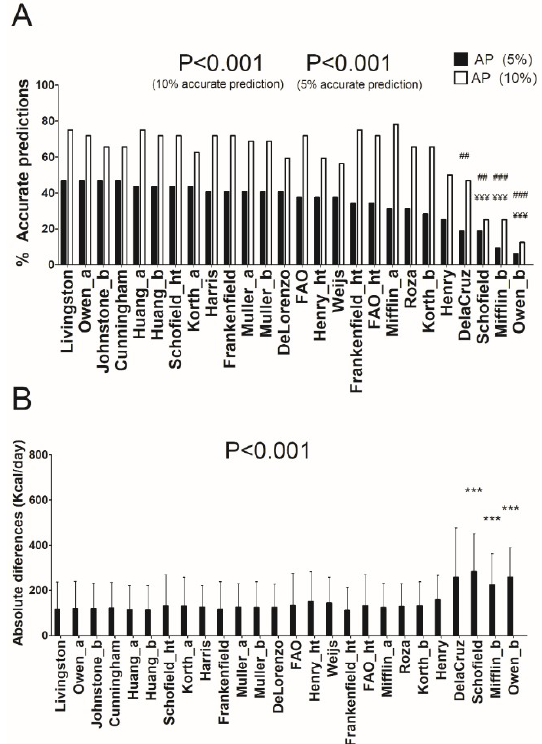
Figure 2. Percentage of accurate prediction of resting energy predictive equations and mean differences between predicted and measured resting energy expenditure in absolute values in overweight individuals. ( A ) Percentage of prediction accuracy at 5% and 10% of resting energy expenditure. ( B ) Mean (SD) differences between predicted and measured resting energy expenditure in absolute values; p value of repeated measures analysis of variance (with Bonferroni post-hoc analysis) among the predictive equations; * = p < 0.05; ** = p < 0.01; *** = p < 0.001 when compared with the predictive equation that presented the least absolute differences with respect to the measured resting energy expenditure (Livingston); ¥ = p < 0.05; ¥¥ = p < 0.01; ¥¥¥ = p < 0.001 when compared with the predictive equation that presented the best resting energy expenditure prediction accuracy (10%) with respect to the measured resting energy expenditure (Roza); # = p < 0.05; ## = p < 0.01; ### = p < 0.001 when compared with the predictive equation that presented the best resting energy expenditure prediction accuracy (5%) with respect to the measured resting energy expenditure (Livingston). AP: Accurate prediction; “_a” refers to predictive equations which require only anthropometric parameters to calculate REE, “_b” refers to predictive equations which require body composition parameters to calculate REE, and “_ht” refers to predictive equations which are proposed by the same author and include